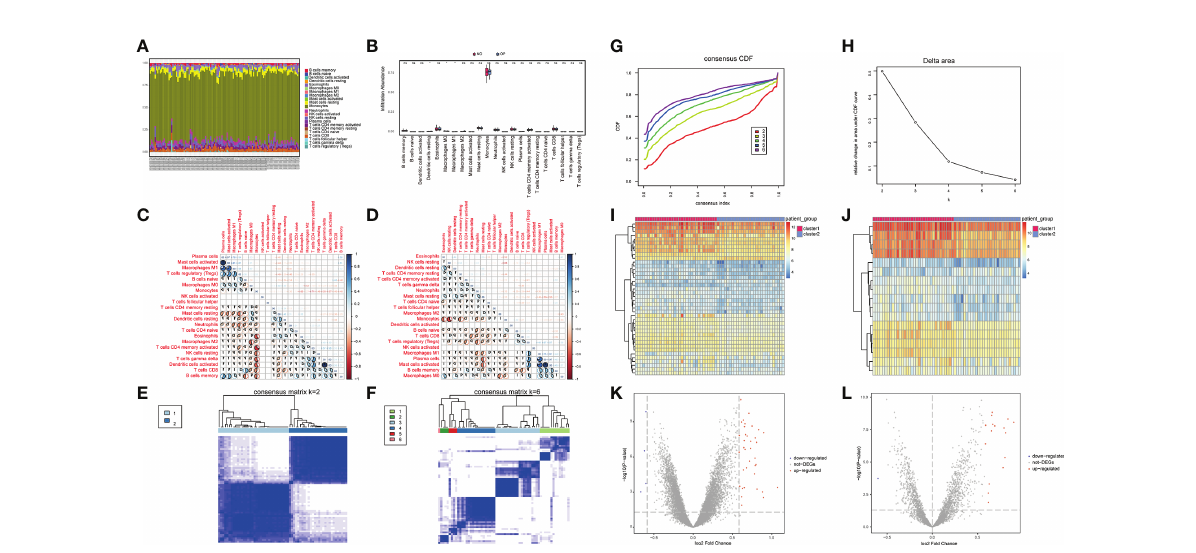
FIGURE 3 Overall immune level analysis and differential analysis of immune signature subtypes in osteoporosis. (A) The content of immune cells between the osteoporosis (OP) and the control group. Different colors represent different immune cells, and the horizontal axis represents the patient id. (B) Histogram of immune cell content, the horizontal axis represents immune cells, the vertical axis represents cell content, red represents the control group samples, and blue represents the disease group samples. 3C-D: Correlation of immune cell content in the normal group (C) and disease group samples (D) ; red indicates a negative correlation, and blue indicates a positive correlation. (E, F) Consistent clustering result graph, different colors represented different groups. (G) Cumulative Distribution Function (CDF) plot of consensus clustering, showing the curve of the CDF as the number of clusters changes. (H) Delta Area plot, calculating the relative change in the area under the curve (AUC) of the CDF as the number of clusters increases. (I, J) Heatmaps of differentially expressed genes (DEG), where red is for cluster 1 and blue is for cluster 2. (K, L) the volcano plot for DEG, the abscissa is log2FoldChange, the ordinate is -log10 (adjust P-value), red nodes indicate up-regulated DEG, gray nodes indicate genes that are not signi fi cantly differentially expressed, and blue nodes indicate down-regulated genes